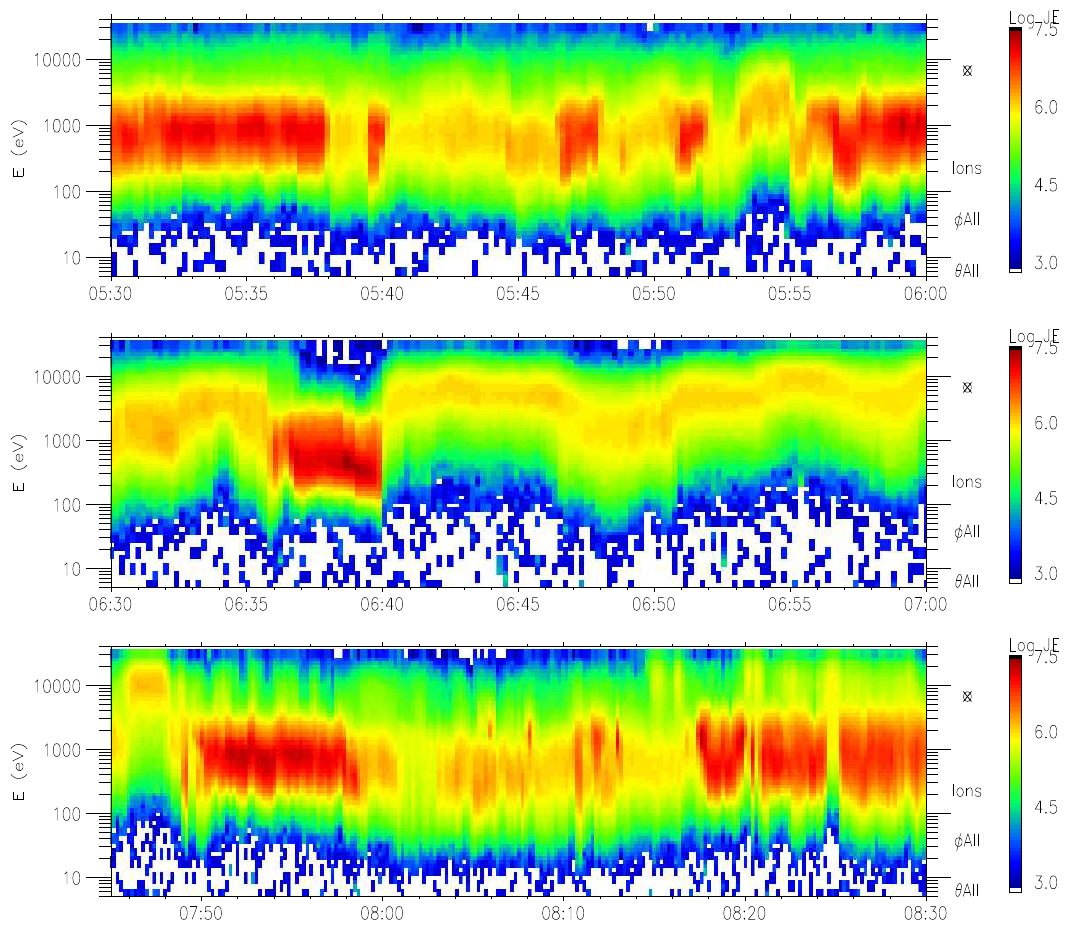
Fig. 2. Omni-directional energy flux spectrogram for ions at sc1 at three intervals (start of the interval corresponding to the red arrows at Fig. 1): 05:30–06:00 UT (top panel), 06:30–07:00 UT (middle), 07:45–08:30 UT (bottom panel).